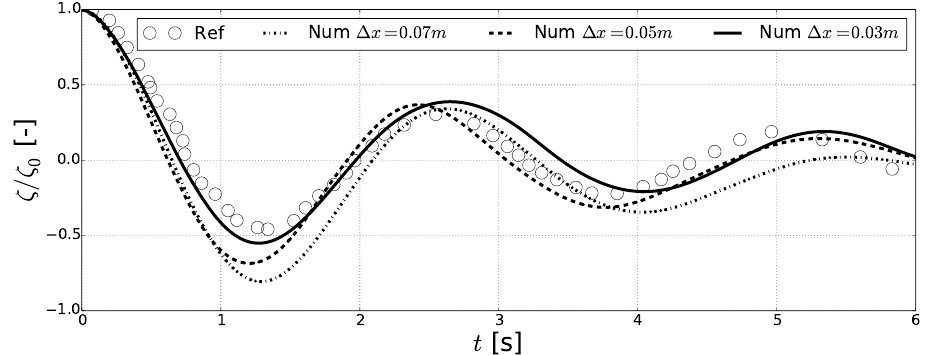
Figure 15. Convergence of the numerical solution for the free heave decay test for the support structure. The numerical reference solution was taken from [54].